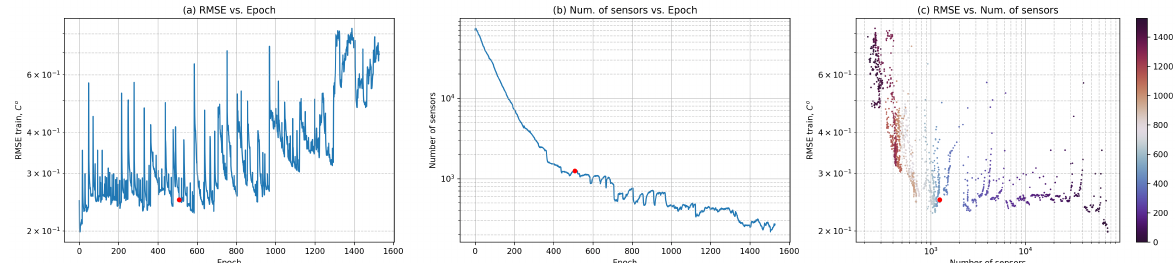
Figure 4. The training dynamics of the Concrete Autoencoder at the sensor sparsification stage. ( a ) RMSE as a function of epoch, ( b ) number of sensors as a function of epoch, and ( c ) RMSE as a function of the number of sensors, with the epoch indicated by the color bar. The red dots in ( a – c ) denotes the Concrete Autoencoder checkpoint used in further